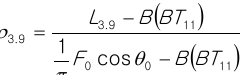
Figure 4. MODIS RGB(R=4.0μm,G=1.6μm,B=2.25μm) color composite images (left column) and cloud screening results (right column) over region of latitude 20°-50° N and longitude 110°-140°E. Cases from upper to lower images for (a) volcanic ash case on 27 January 2011, (b) smoke case on 4 February 2011, (c) Asian dust case on 1 May 2011, and (d) relative clear sky case on 25 October 2014, respectively. In the cloud screened image, colors represent clear sky(black), sun-glint region(purple), cloudy over ocean(orange), turbid water(yellow), and cloudy over land (white), respectively. Red and blue circles in (a) indicate ash plume and bright dusty surface in the